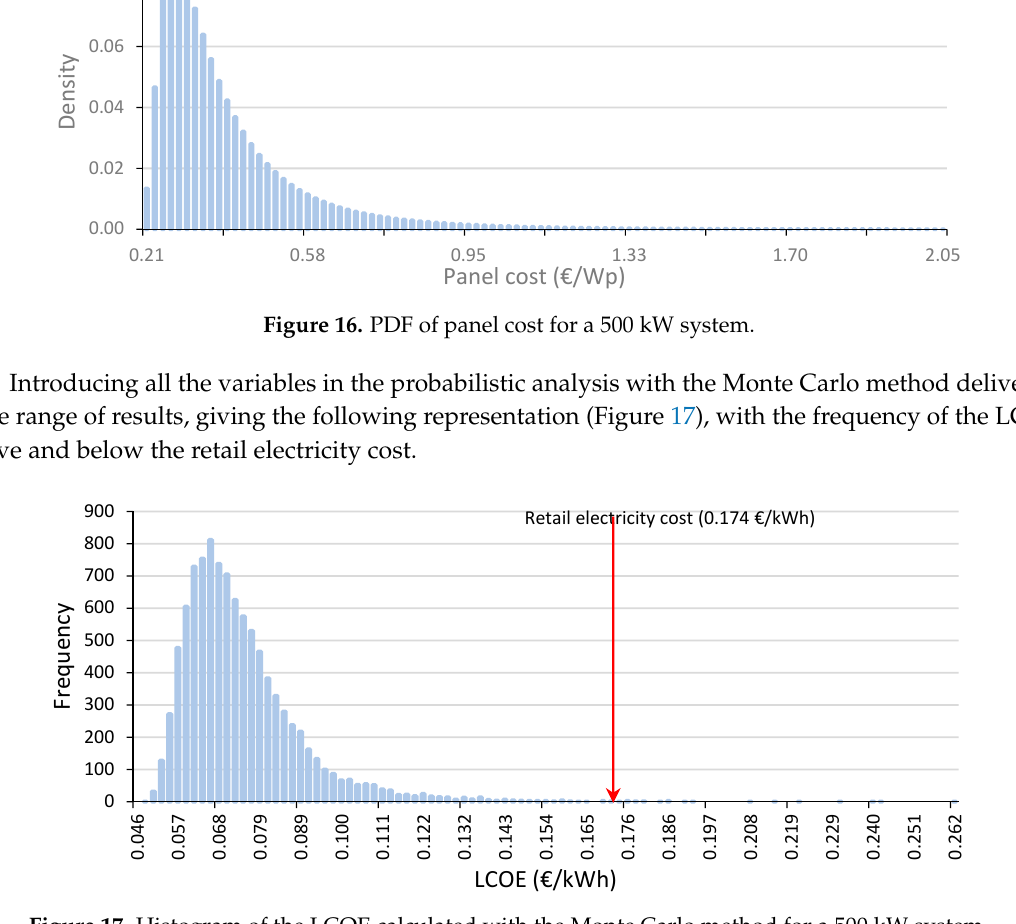
Figure 18. Histogram of the IRR calculated with the Monte Carlo method for a 500 kW system.